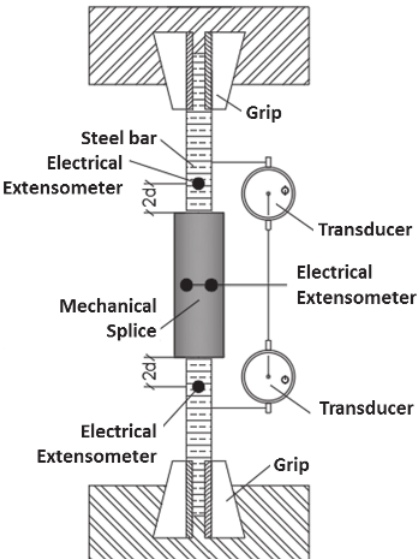
Individual displacement transducers used in the measurement of the slip parameter in test methods 1 and